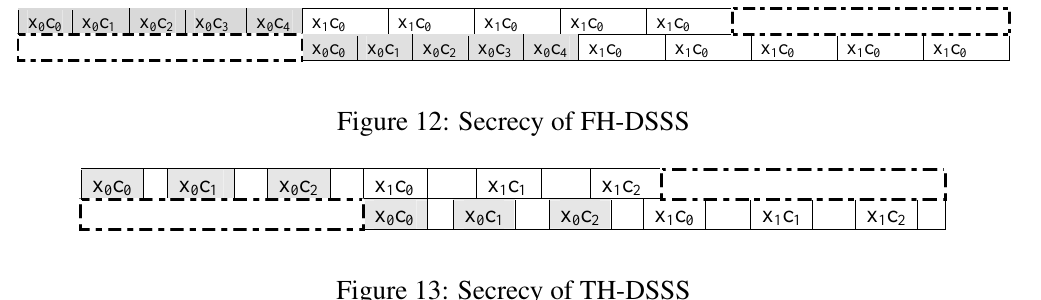
Figure 13: Secrecy of